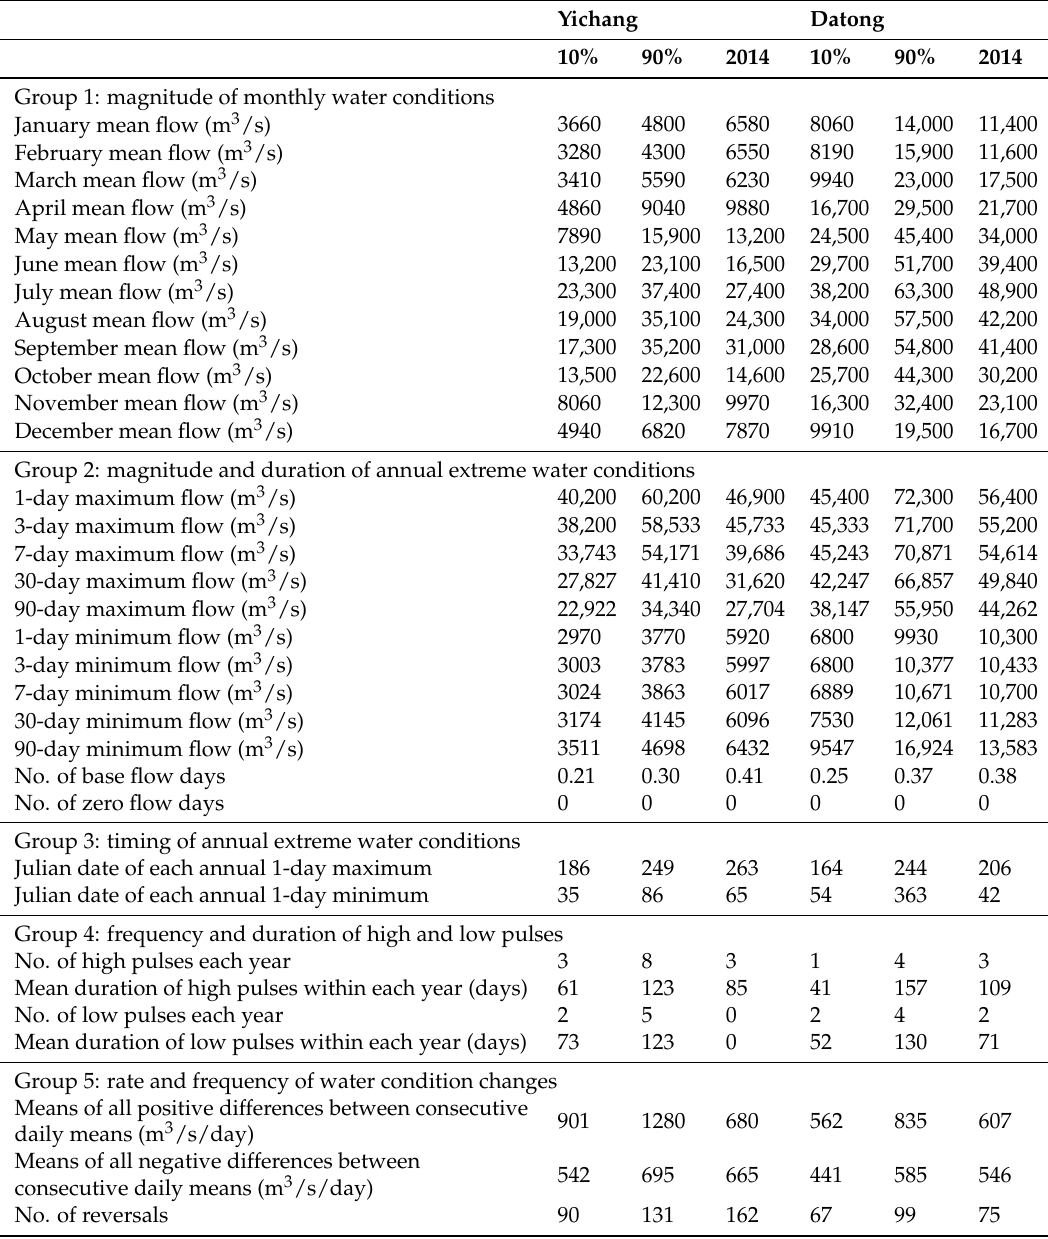
Table 8. Comparison of IHA factors and normal ranges in 2014 at Yichang and Datong stations. Yichang Datong